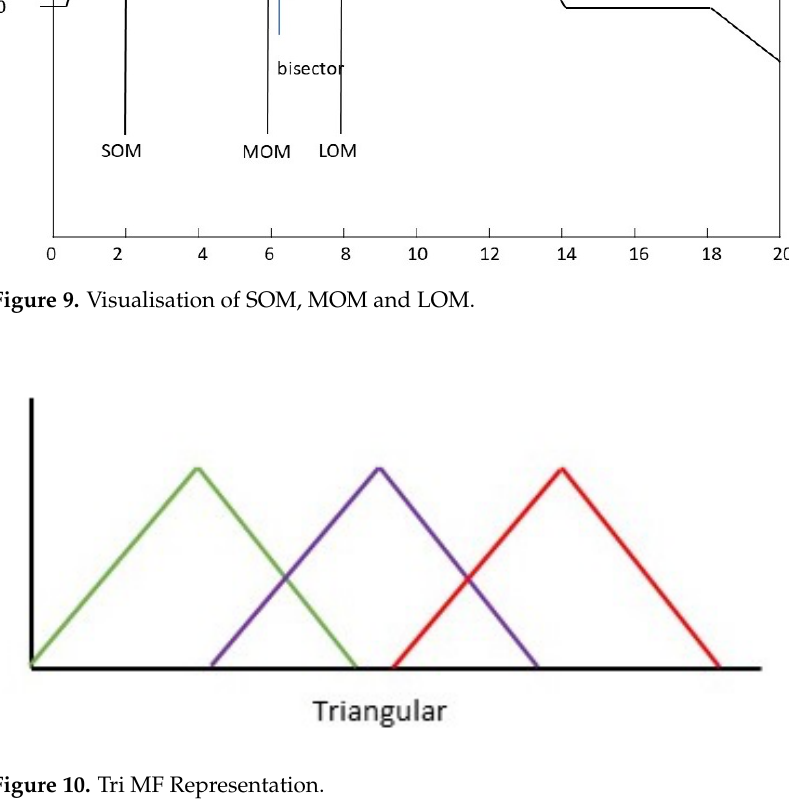
Figure 10. Tri MF